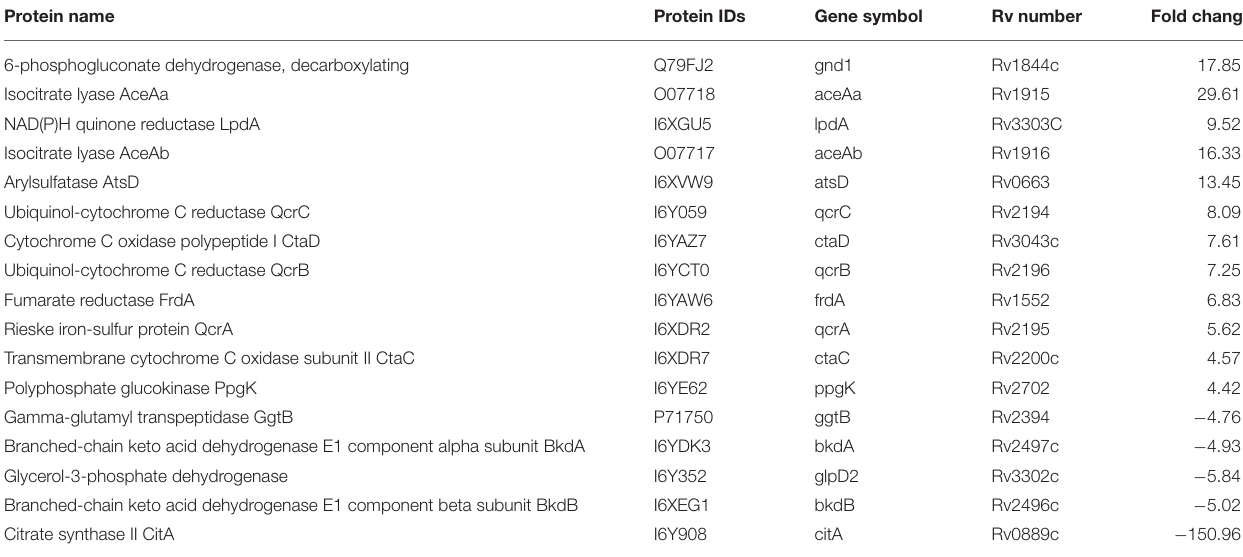
TABLE 5 | List of the differentially abundant proteins involved in energy metabolism in M. tuberculosis lineage 7 (L7-35 and L7-28) vs. lineage 4 (H37Rv)